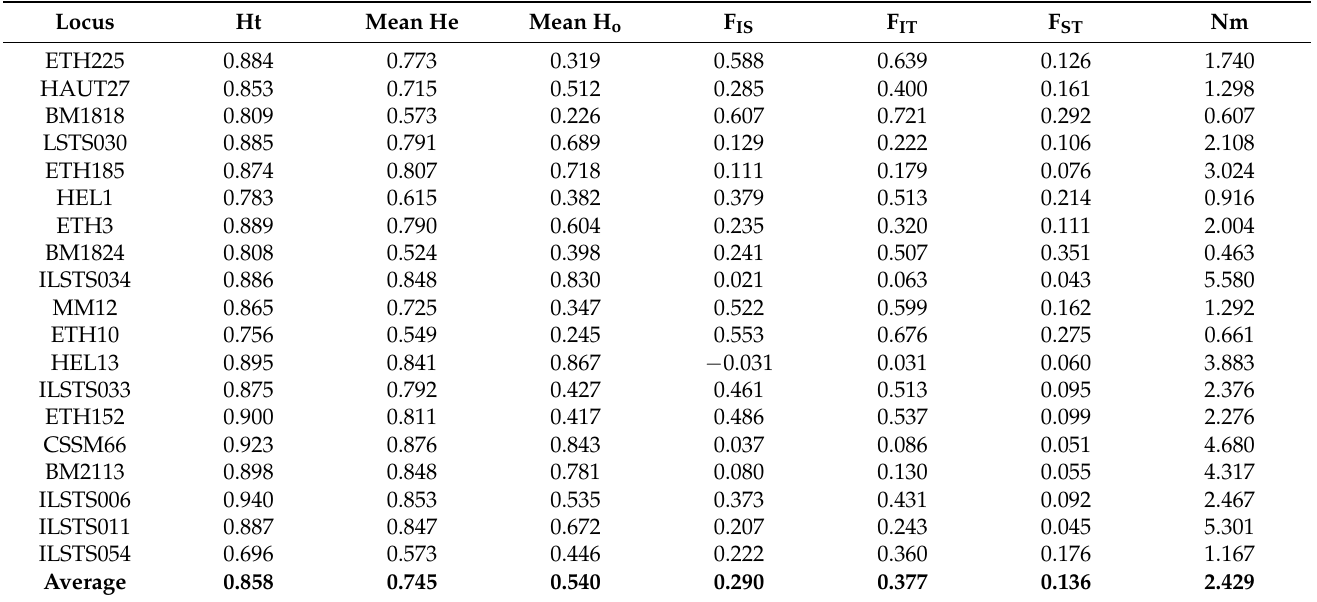
Table 2. Global gene diversity and F-statistics for each of 19 SSR loci analyzed across three bovine populations (163 Mithun, 10 gaur, and 25 Tho-tho